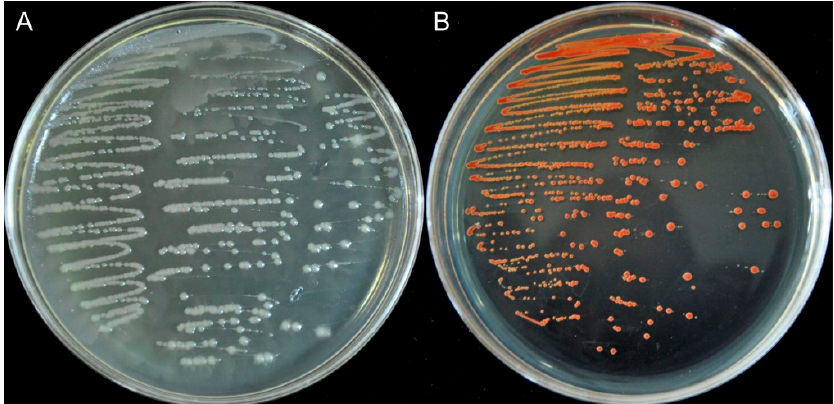
Figure 1. Growth of strain YC801 on YEP (yeast extract peptone) agar plates without ( A ) and with ( B ) 5.0 mM selenite. The red colony color indicates that the strain reduced selenite to elemental red selenium (Se 0 ).